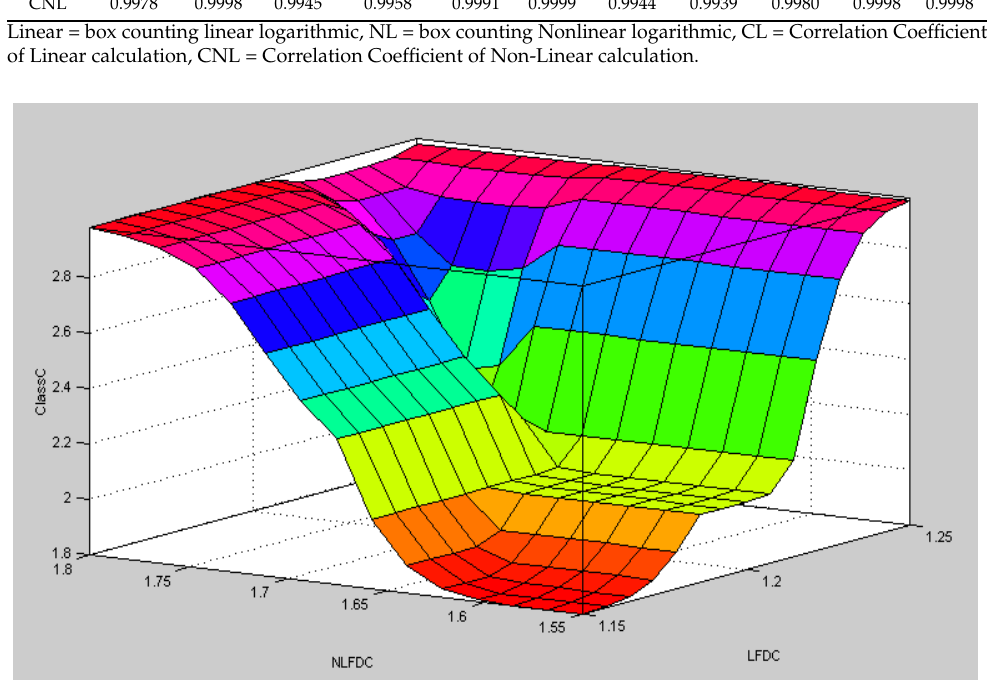
Figure 11. Testing dataset of confirmed cases for the 15 countries (1 April 2020 to 12 July 2020).